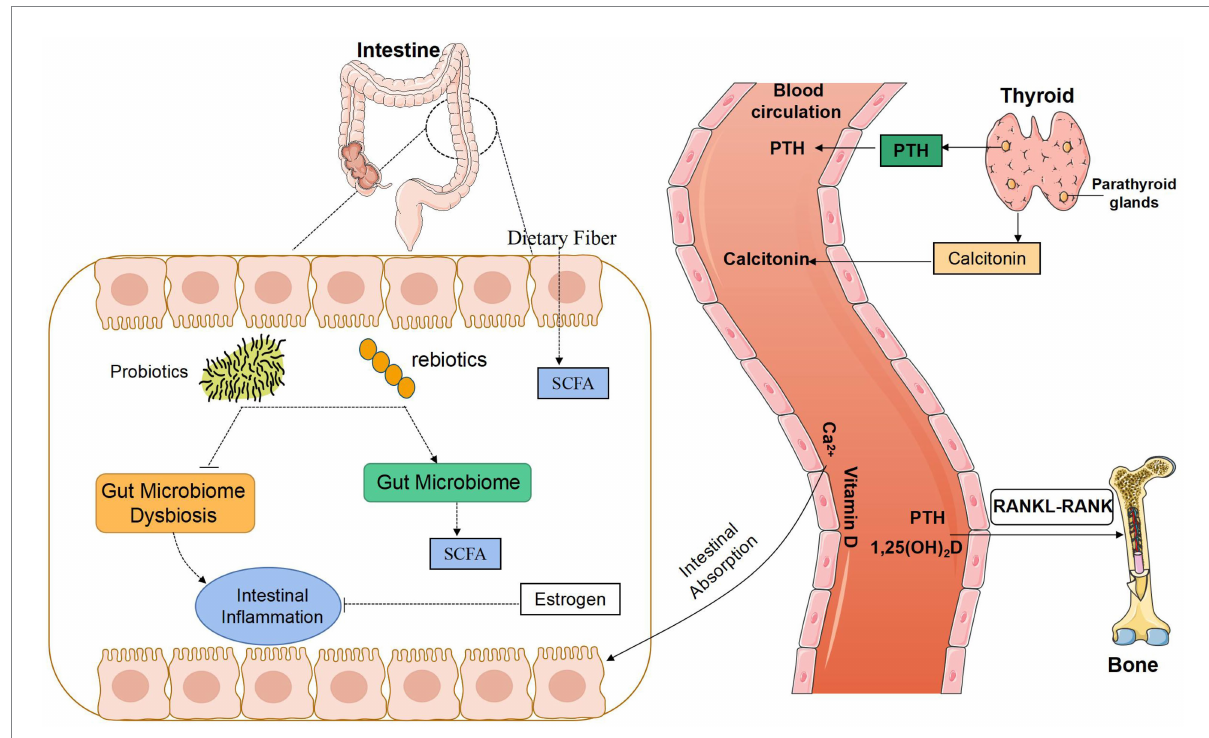
FIGURE 2 Potential relationship between gut microbiota and bone metabolism. SCFA, Short-chain fatty acids; PTH, parathyroid hormone; RANK, receptor activator of the NF-kB; RANKL, receptor activator of the NF-kB